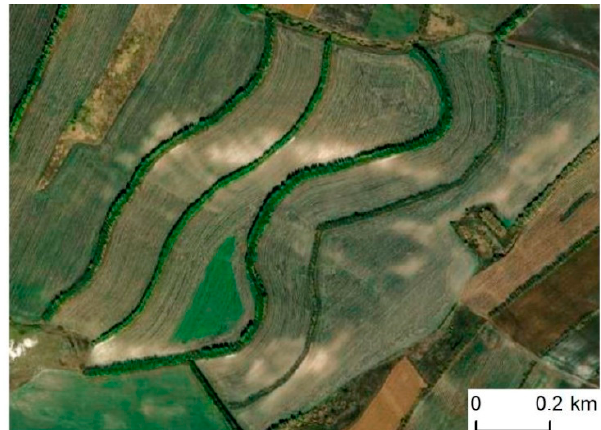
Figure 9. An example of the contour-reclamation organization of cropland in Belgorod Oblast: erosion-control forest belts (Krasnogvardeisky district).